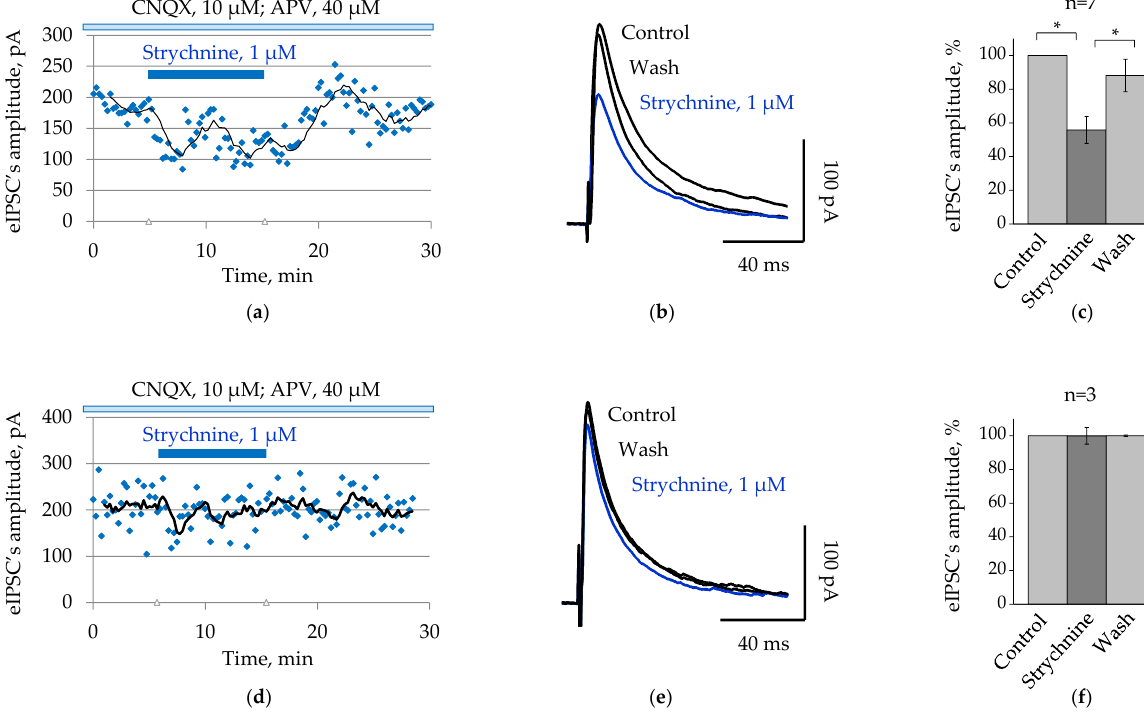
Figure 4. Strychnine-sensitive and strychnine-resistant GABAergic eIPSCs were recorded in the hippocampal CA1 pyramidal cell layer: ( a , d ) the original eIPSCs’ amplitude values are continuously displayed on the scatter plot with a 5-period moving-average trendline (black line): the first cell responded with a reversible decrease in the amplitude of GABAergic eIPSCs to the administration of strychnine (1 µM), whereas in the second cell strychnine did not affect the GABAergic eIPSCs; ( b , e ) superimposed traces of average GABAergic eIPSCs ( n = 20 – 27) recorded in control ACSF, after application of strychnine and washing (mouse P6); ( c , f ) normalized to control values mean amplitudes of GABAergic eIPSCs after application of strychnine (1 µM) and subsequent washing for strychnine-sensitive ( c ) and strychnine-resistant ( f ) neurons (mean percent ± SEM; P6 – 15). * Significant difference with p < 0.05 (paired Student’s t -test).